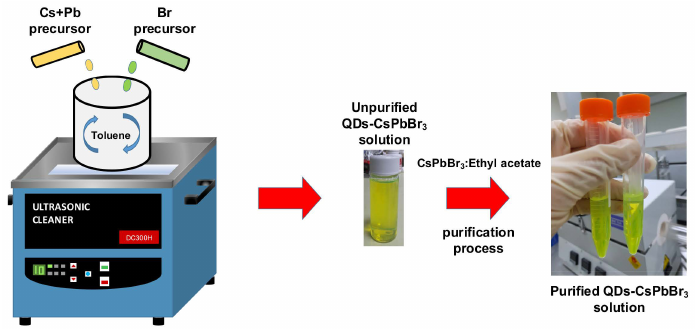
Figure 1. Perovskite quantum dots (QDs)-CsPbBr 3 solution fabrication process